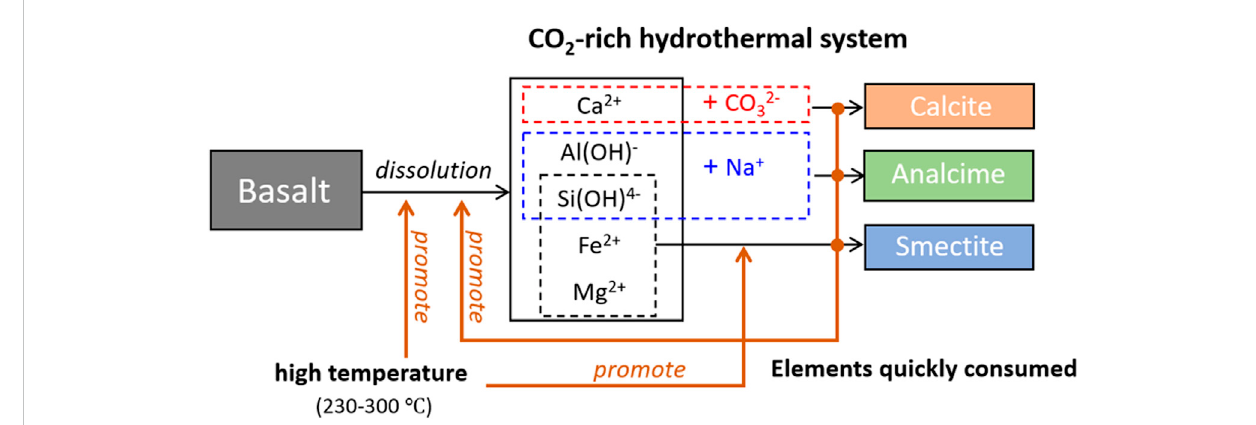
FIGURE 12 A conceptual graph of basalt alteration with the storage of CO 2 assisted by CO 2 -rich hydrothermal